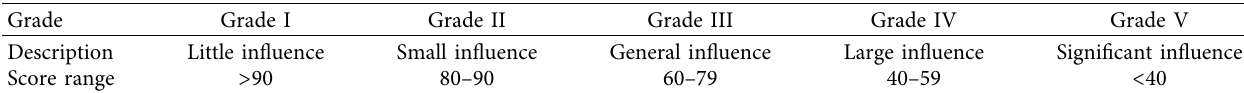
Table 10: Relationship between scores and safety grades.